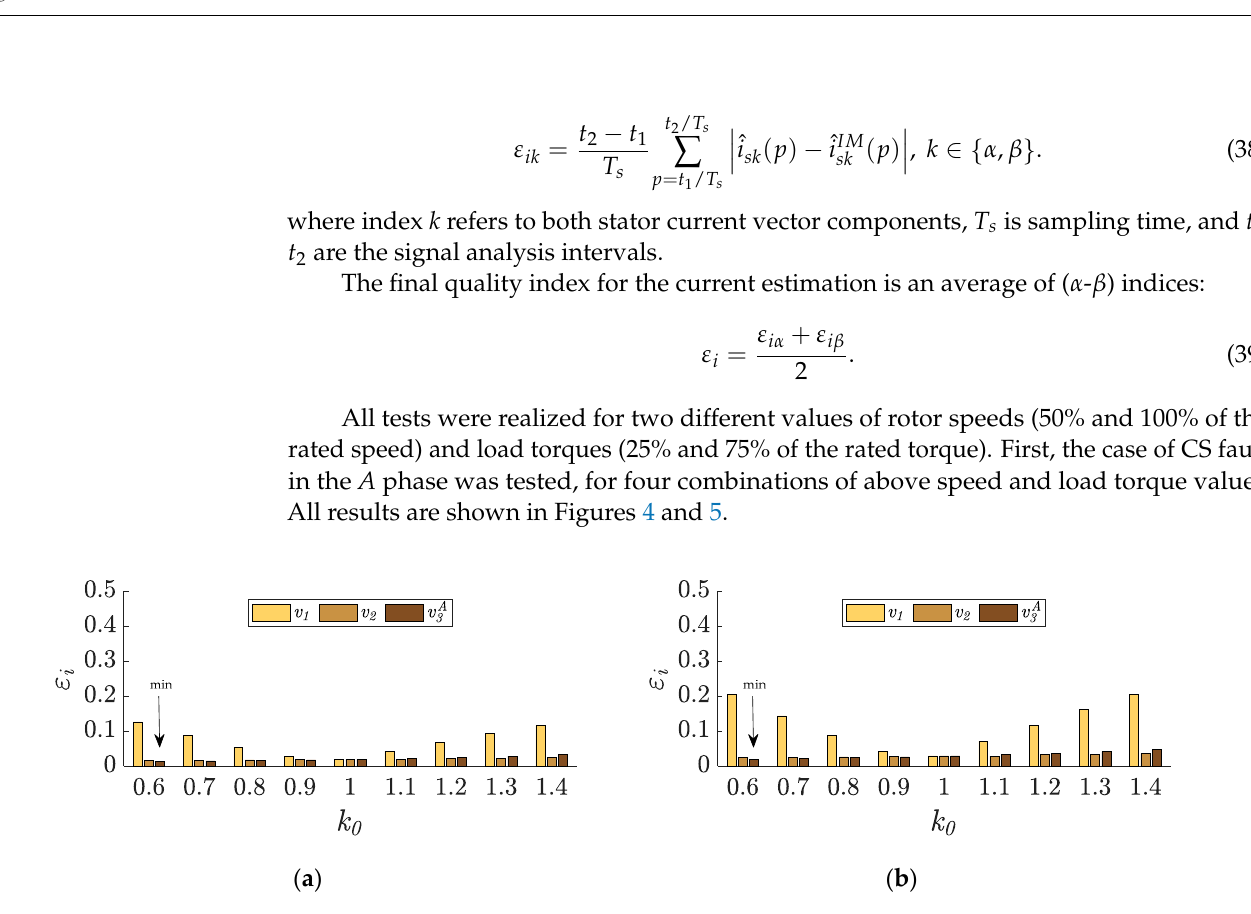
Figure 4. Error index of stator current estimation for ω m = 0.5 ω mN and faulty CS in phase A : ( a ) t L = 0.25 t LN ; ( b ) t L = 0.75 t LN .